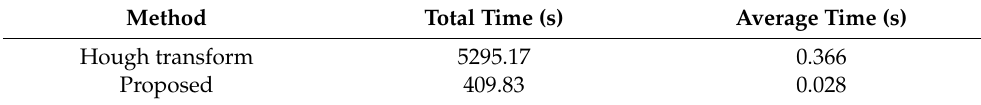
Table 3. The time consumption of the proposed method and the Hough transform method for dataset